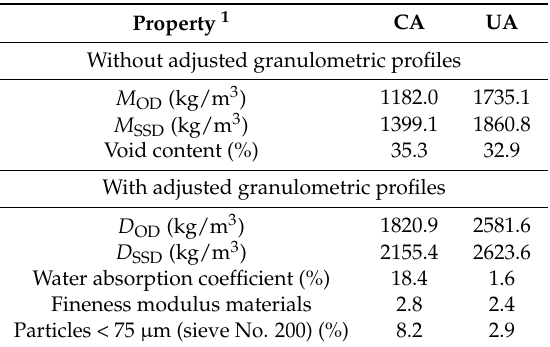
Table 1. Physical properties of aggregates.